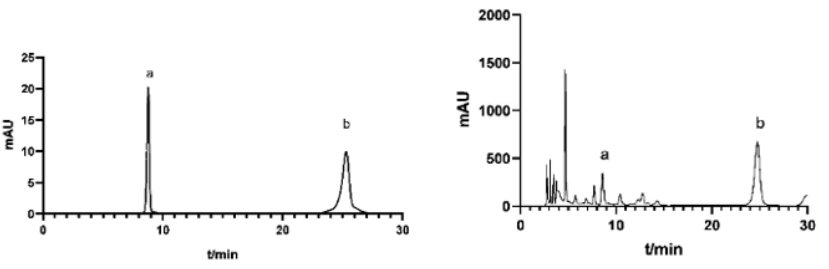
Figure 7. HPLC diagram of Yuanzhi reference substance and Yuanzhi extract (a: PolyIII; b: DISS). DISS and PolyIII content were measured by the corresponding peak area transformation. The results showed that the content of DISS was higher than that of PolyIII in the sample. Under these conditions, the retention times of DISS and PolyIII were 8.73 and 25.4 min, respectively. The RSD values of peak area for DISS and PolyIII were 0.85% and 0.56% of stability, which indicated that it was great from 0 to 16 h at room temperature. The repeatability and precision of DISS and PolyIII were 0.77%, 0.69% and 0.53%, 0.81%, respectively.